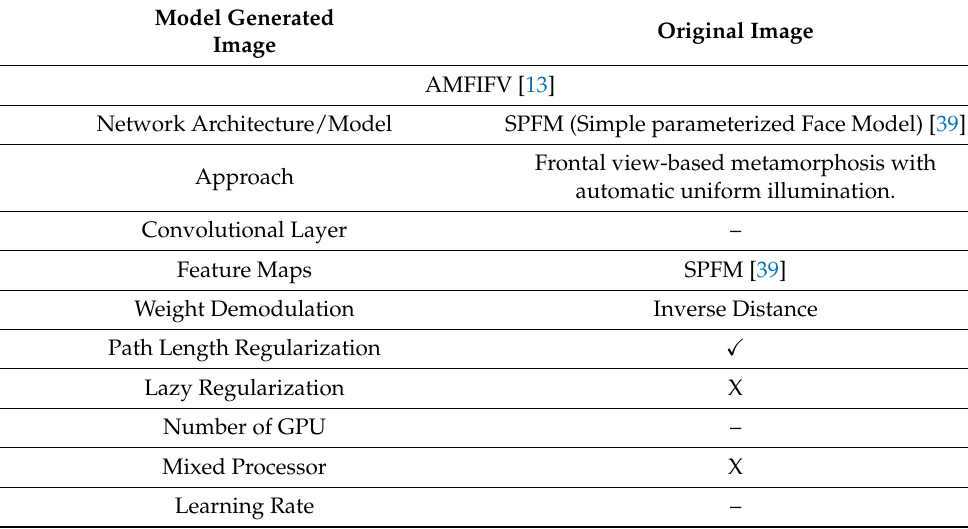
Table 6. Comparison with model [31] based on AMFIFV [15].